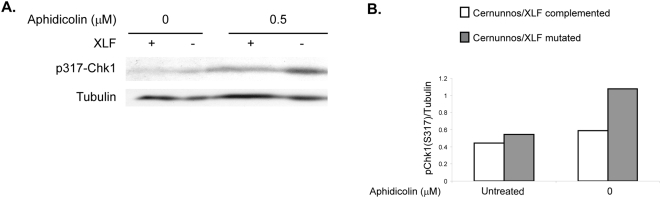
The Cernunnos/XLF mutation lead to an increased activation of Chk1 in response to replication stress.A. Cernunnos/XLF mutated and complemented cells were treated with 0.5 µM aphidicolin for 24 hours. Protein extracts were prepared and analyzed by immunoblotting with anti- pChk1(S317) antibodies. Untreated cells were analyzed as control. B. Quantification of pChk1(S317) levels in Cernunnos/XLF mutated and complemented cells following 0.5 µM aphidicolin treatment for 24 hours. pChk1(S317) level was normalized to Tubulin control.